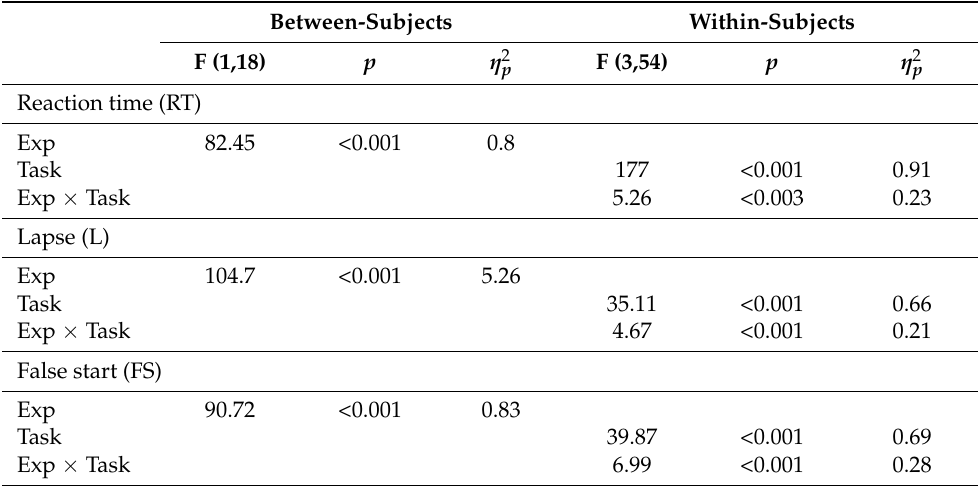
Table 3. Results of the mixed model analysis of variance on PVT measures: Exp is expertise factor (experts vs. novices) related to the between-subjects design, and task is the task factor (tasks 1, 2, 3, and 4) related to the within-subjects design.